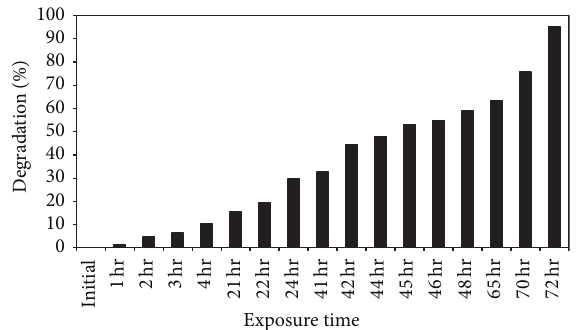
Figure 10: Percentage of dye degradation by 10mg of synthesized silver nanoparticles at different functional time